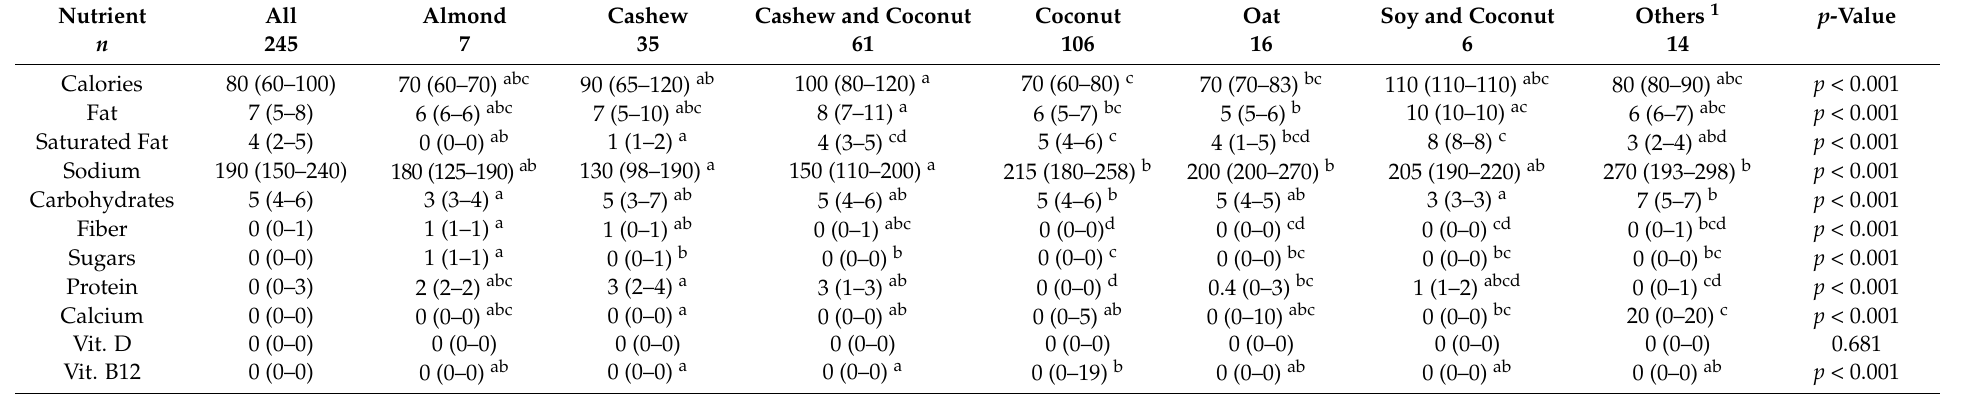
Table 1. The median (Q1–Q3) values of calories and 10 nutrients of non-dairy cheese alternatives/serving classified according to their